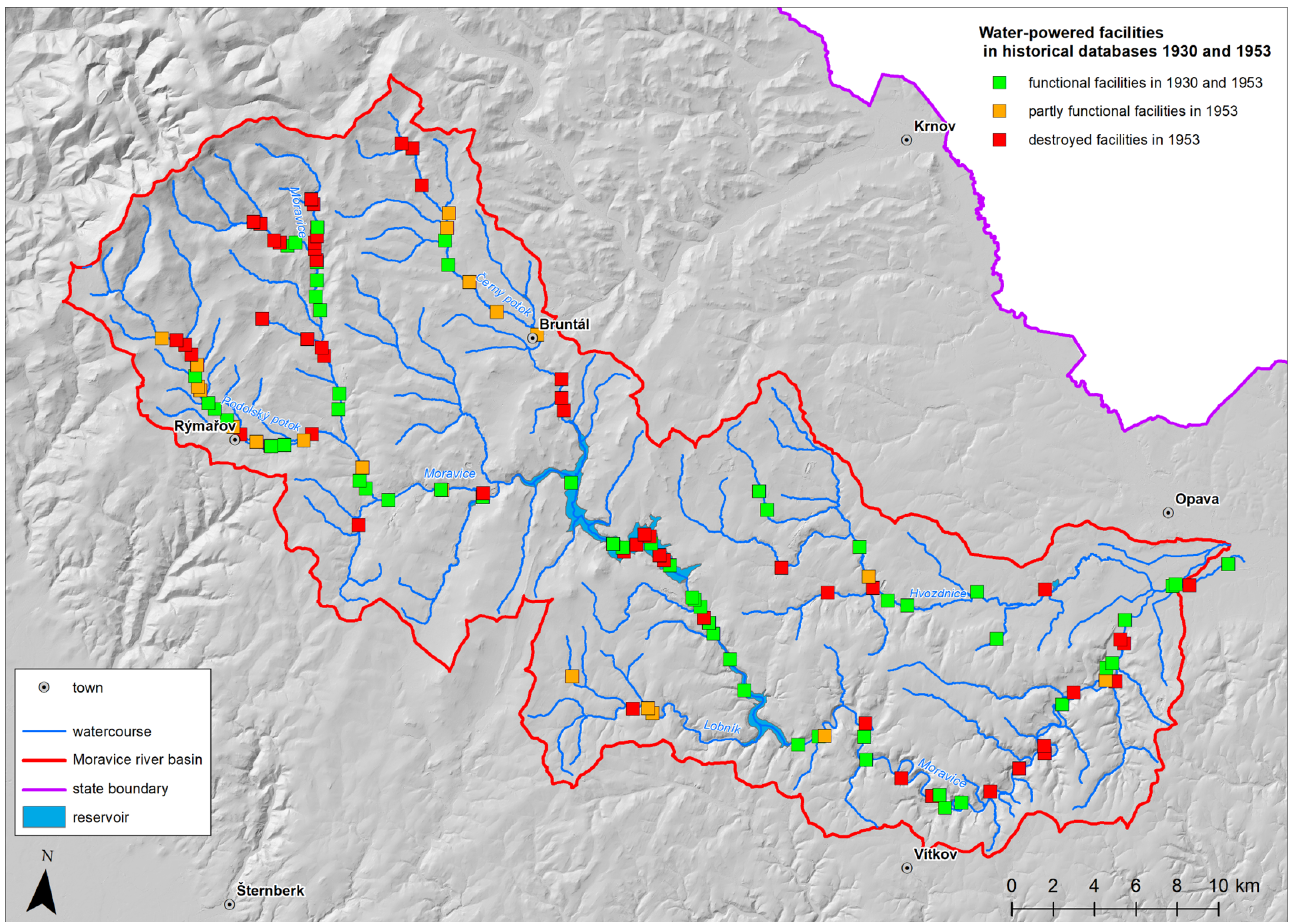
Figure 4. The preservation of the facilities, based on the data from the 1930 and 1953 historical databases.